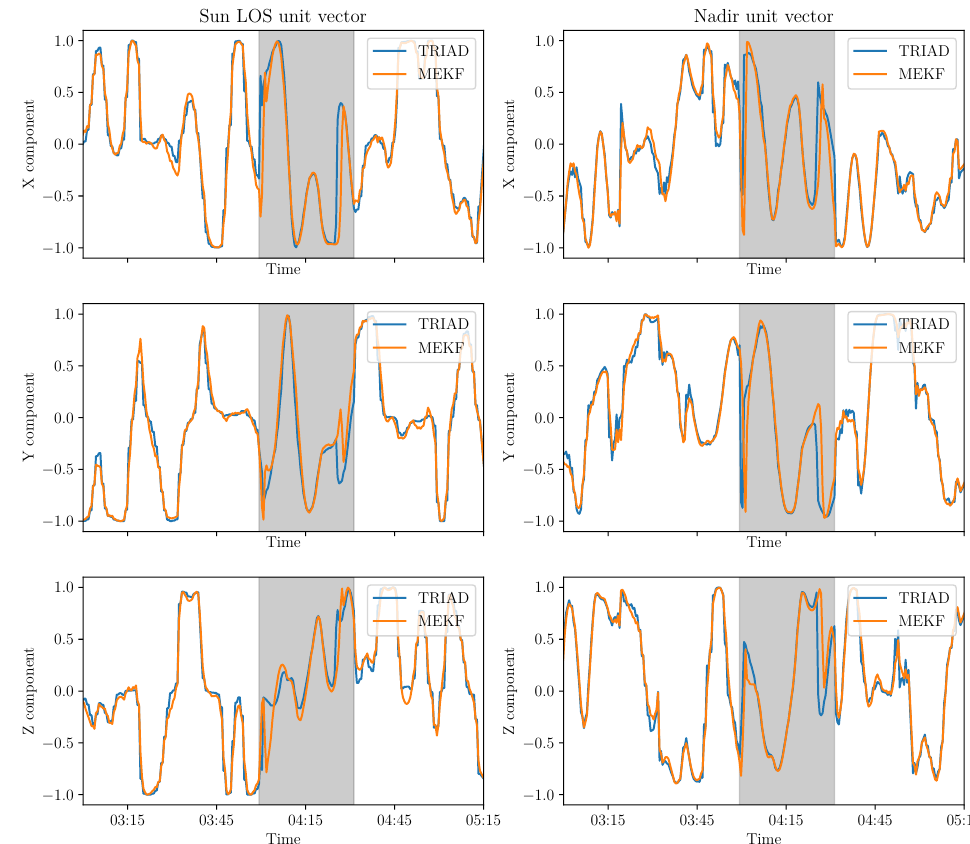
Figure 10. First lights of the Sun LOS and nadir coordinates in the satellite body frame based on MEKF and TRIAD on 2 March 2021 (representative period in the case of measurements at 30 s intervals almost continuously with eclipse phase in